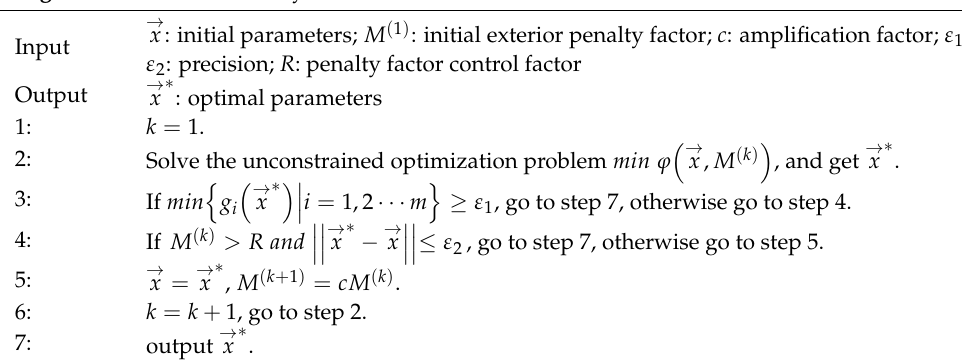
Algorithm 1 Exterior Penalty Function